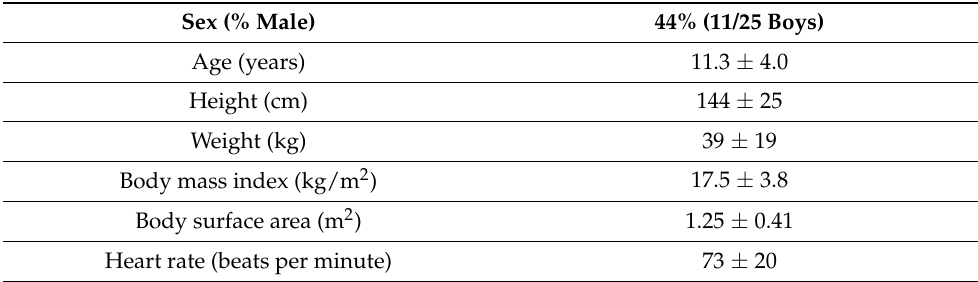
Table 1. Baseline characteristics ( n = 25).